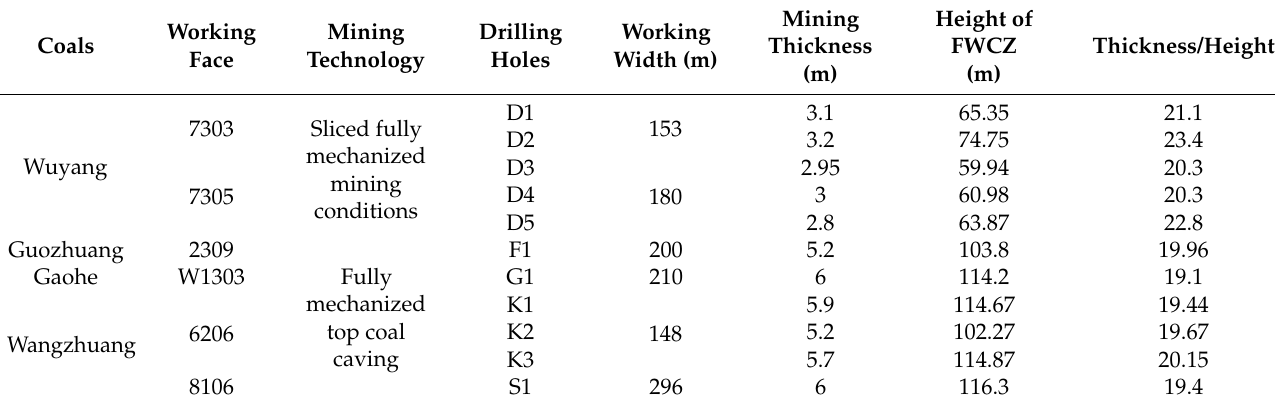
Table 2. Measured heights of FWCZs in Lu’an Mine.